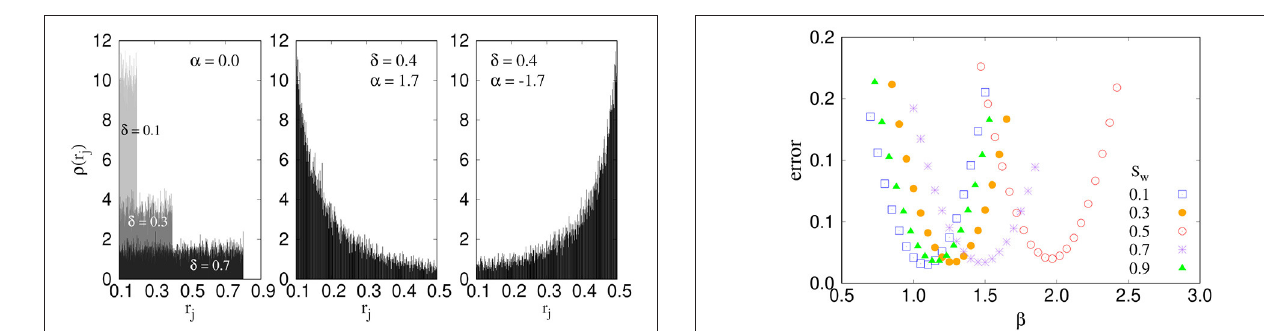
FIGURE 2 | The error associated with least-square fitting of the numerical results to Equation (3) as a function of the trial values of β . Results are shown for five different saturations S w . The minima of these plots decide the final values of β and P c .